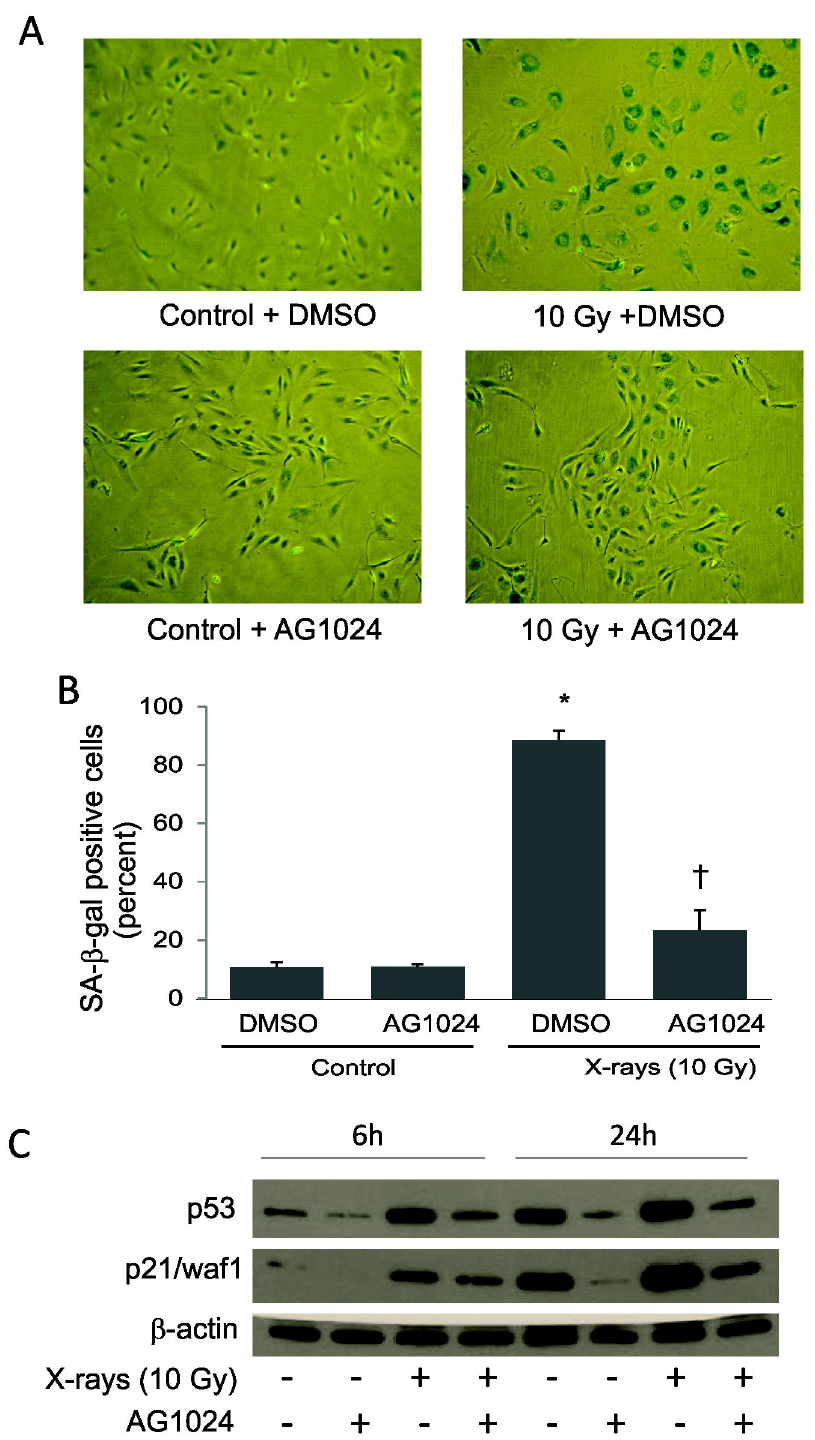
Figure 3. Attenuation of radiation-induced accelerated senescence by AG1024. Subconfluent HPAEC were pretreated with 5 μM AG1024 or vehicle (DMSO) for 30 minutes, exposed to 10 Gy X-rays and then incubated until time of assay. (A) Representaive pictures of SA-β-gal staining at 4 days post-irradiation (B) Percentage of SA-β-gal positive cells was counted in at least 3 random fields. Graph represents means ± SEM, n = 6. * indicates statistical significance from controls, p<0.05. (C) Representative western blotting for p53 and p21/waf1 expression at indicated time-points post-irradiation in the presence of AG1024 or DMSO.